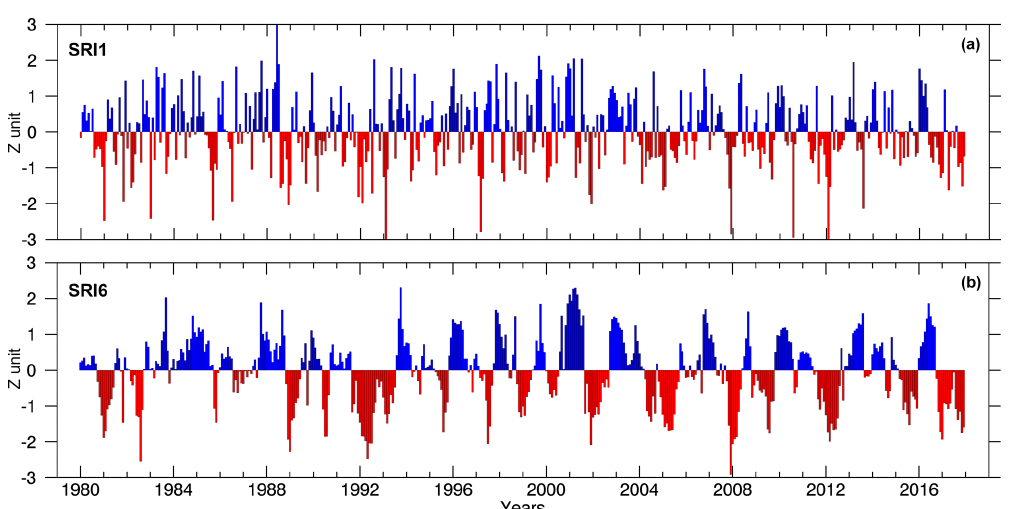
Figure 17. Temporal evolution of the standardized runoff index computed for (a) 1-month and (b) 6-month temporal scales in the MLSHD. Period of 1980–2017.